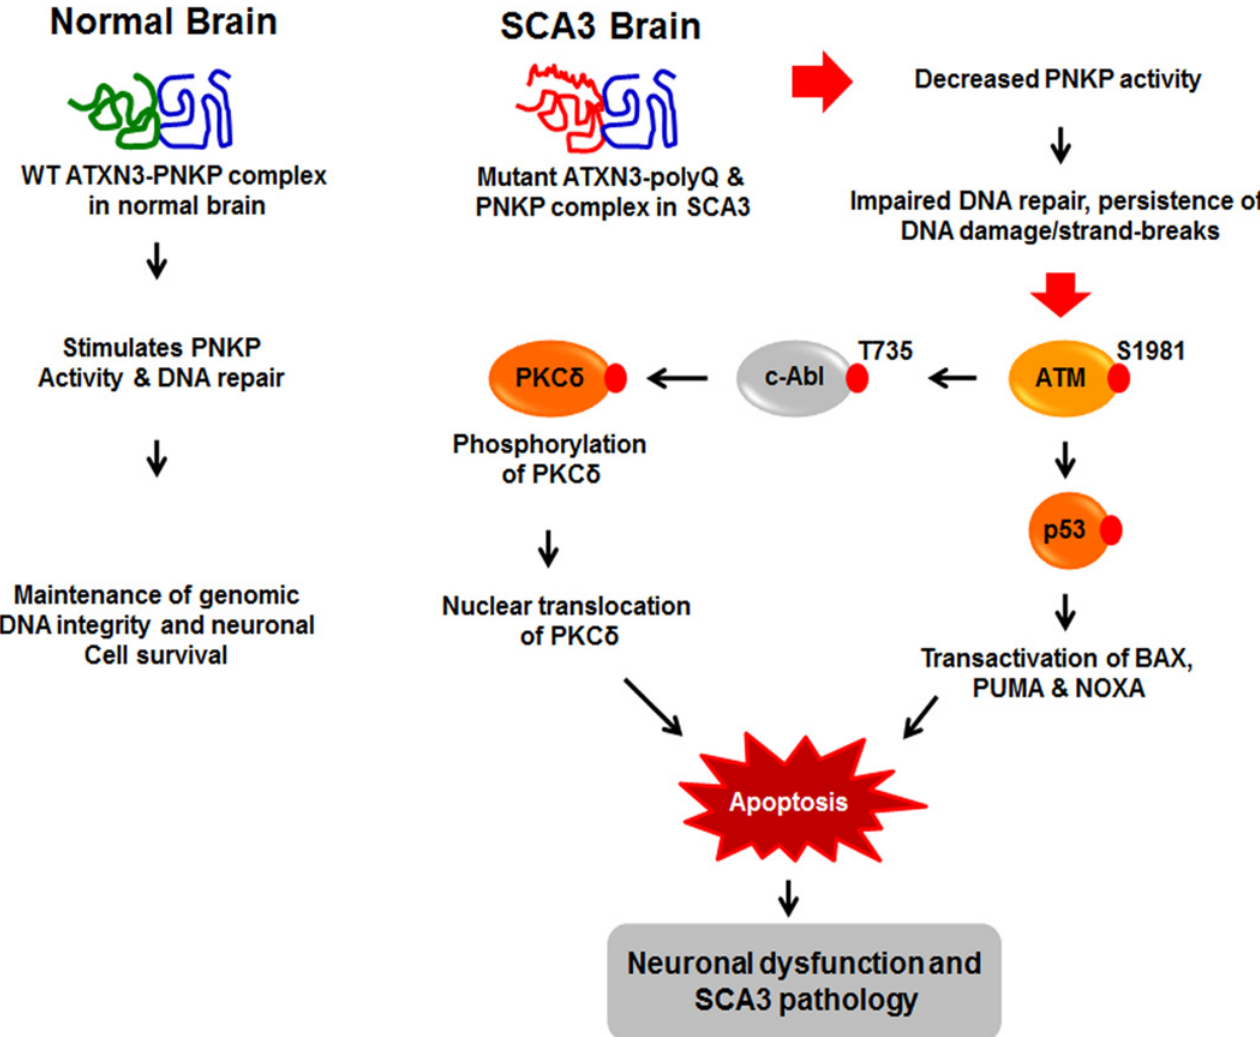
Figure 8. Proposed mechanism where interaction of PNKP with mutant expanded polyQ-containing ATXN3 abrogates PNKP ’ s 3 ’ -phosphatase activity. This atypical interaction perturbs the efficacy of DNA repair, leading to the persistent accumulation of DNA damage/strand breaks in SCA3. The wild-type ATXN3 binds with and stimulates PNKP ’ s enzymatic activity to repair damaged DNA, contributing to genomic DNA sequence integrity and neuronal survival. By contrast, mutant ATXN3 interacts with and decreases PNKP ’ s 3 ’ -phosphatase activity, leading to the persistent accumulation of DNA damage in the post-mitotic neurons and resulting in chronic activation of the DNA damage-response ATM ! p53 signaling pathway in SCA3. This triggers apoptosis by increasing expression of such p53 target genes as BAX, PUMA and NOXA in SCA3. In parallel, activated ATM phosphorylates c-Abl kinase, which in turn phosphorylates PKC δ , facilitating nuclear translocation of PKC δ and thus further amplifying the pro-apoptotic output in SCA3 ultimately leading to neuronal death in